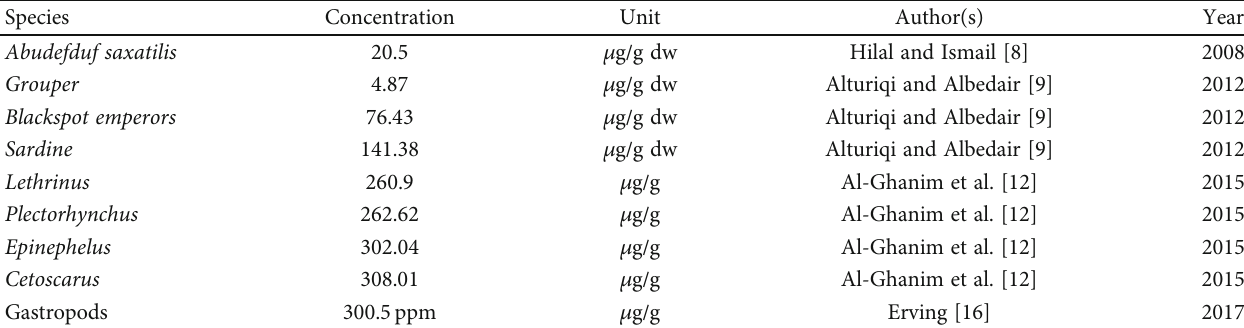
Table 7: Bioaccumulation of iron reported from the Red